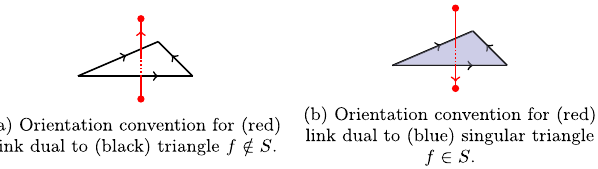
˜ P . We perform gauge